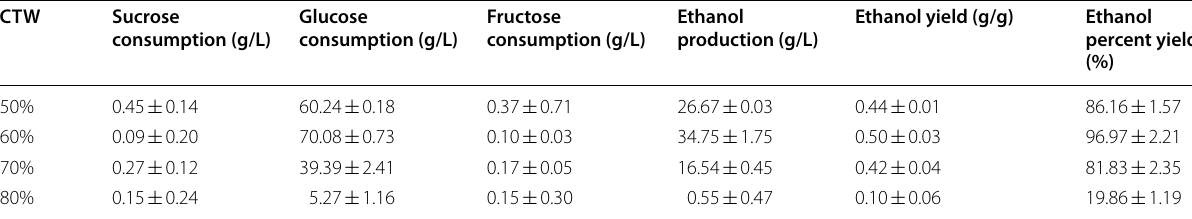
No sorbitol detected